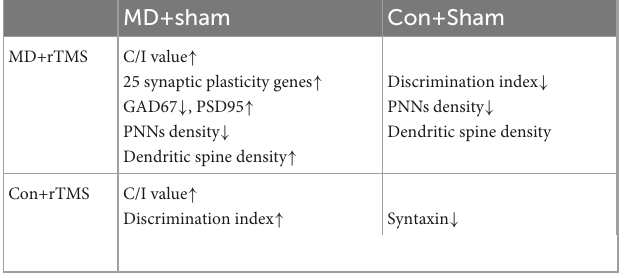
TABLE 2 Results comparison between sham stimulation-treated groups and repetitive transcranial magnetic stimulation (rTMS)-treated groups. MD+sham